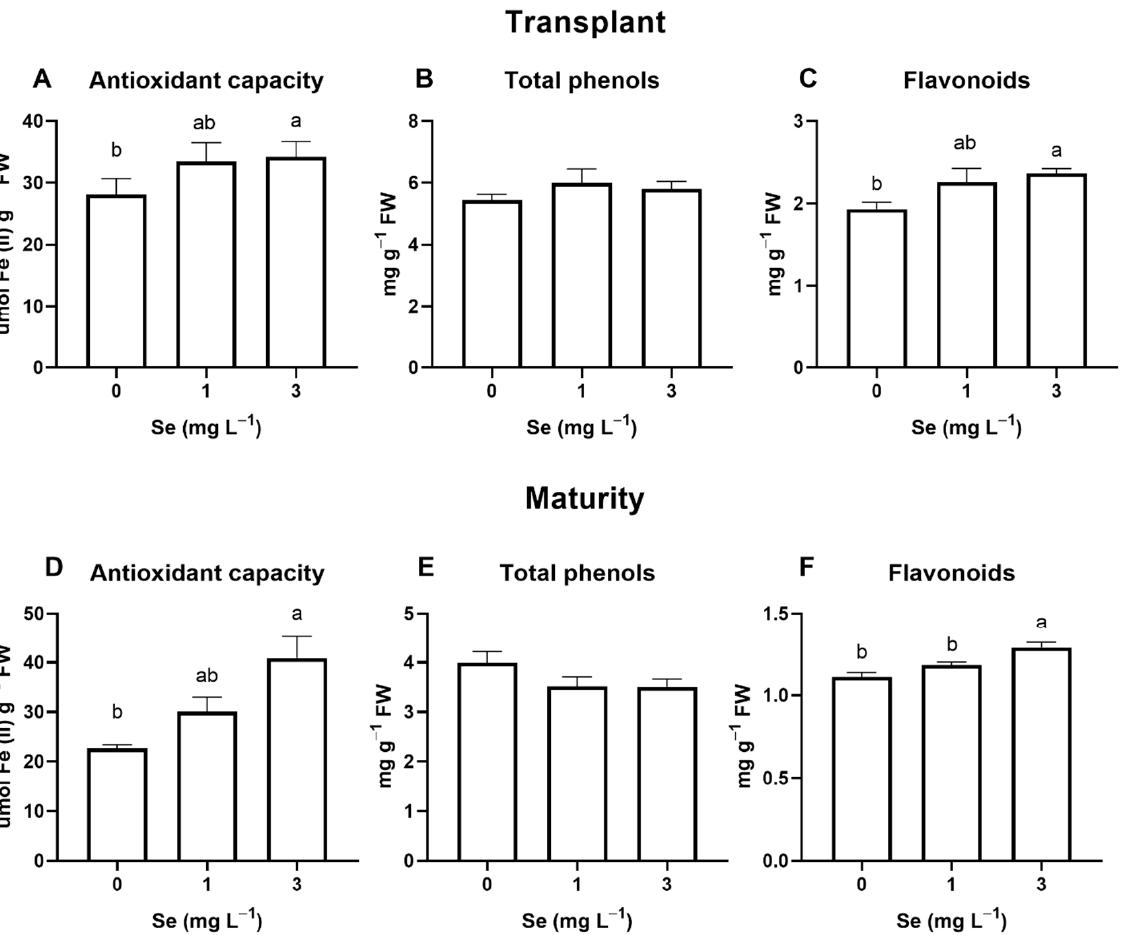
Figure 4. Antioxidant capacity, total phenol and flavonoid contents, measured at transplant ( A – C ) and maturity ( D – F ), in leaves of lettuce plants treated with different concentrations of Se at pre- transplanting. In subfigures ( A , C , D , F ), means ( n = 3) flanked by different letter are statistically different for p = 0.05 after Tukey ’ s test.